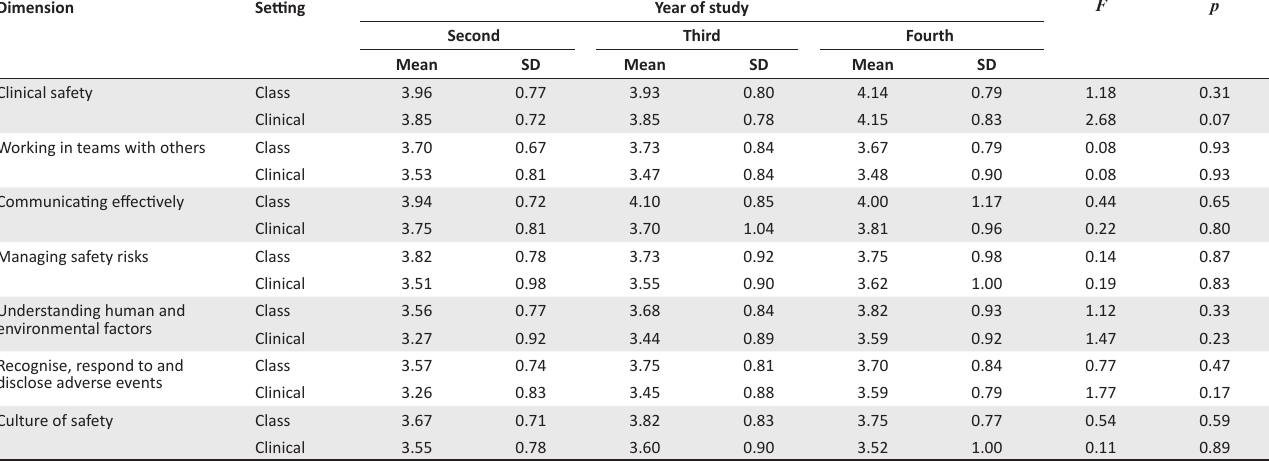
TABLE 3: Relationship between the year of study and self-reported patient safety competence.